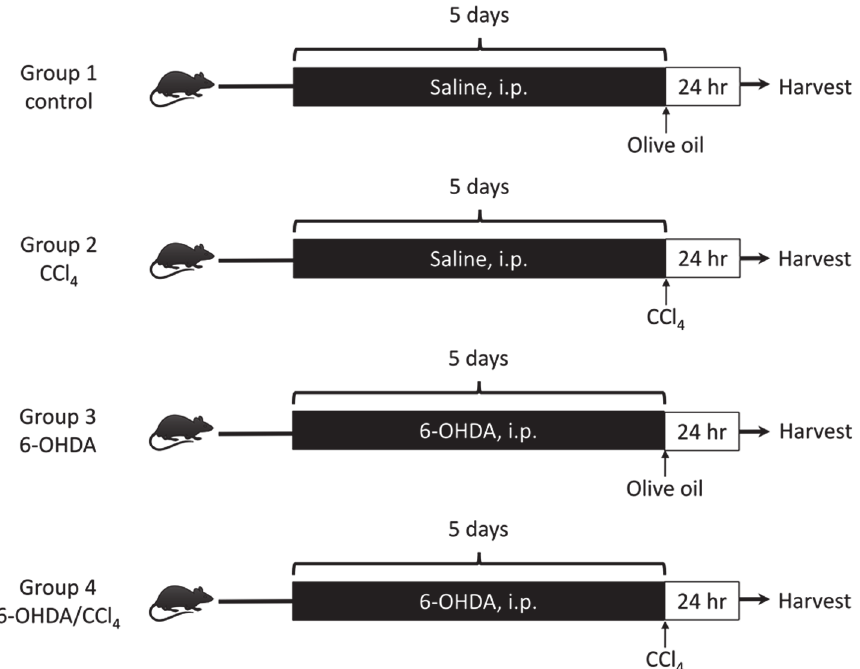
Fig 1. Schematic diagram of the study protocol. Mice were randomly assigned in a blinded manner to one of four groups: group 1, control (n = 6), group 2, CCl 4 (n = 6), group 3, OHDA (n = 6), and group 4, 6-OHDA/ CCl 4 (n = 6). The animals underwent 5 days of intra-peritoneal (i.p.) administration of 6-OHDA or saline. After ablation of the sympathetic nervous system, the animals were given CCl 4 or vehicle on day 6, and sacrificed 24 hours after CCl 4 poisoning. 6-OHDA = 6-hydroxydopamine, CCl 4 = carbon tetrachloride.